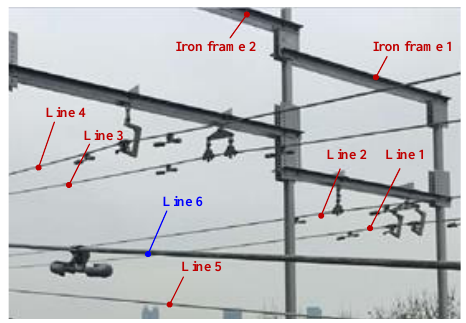
Figure 16. Photo of the test site.